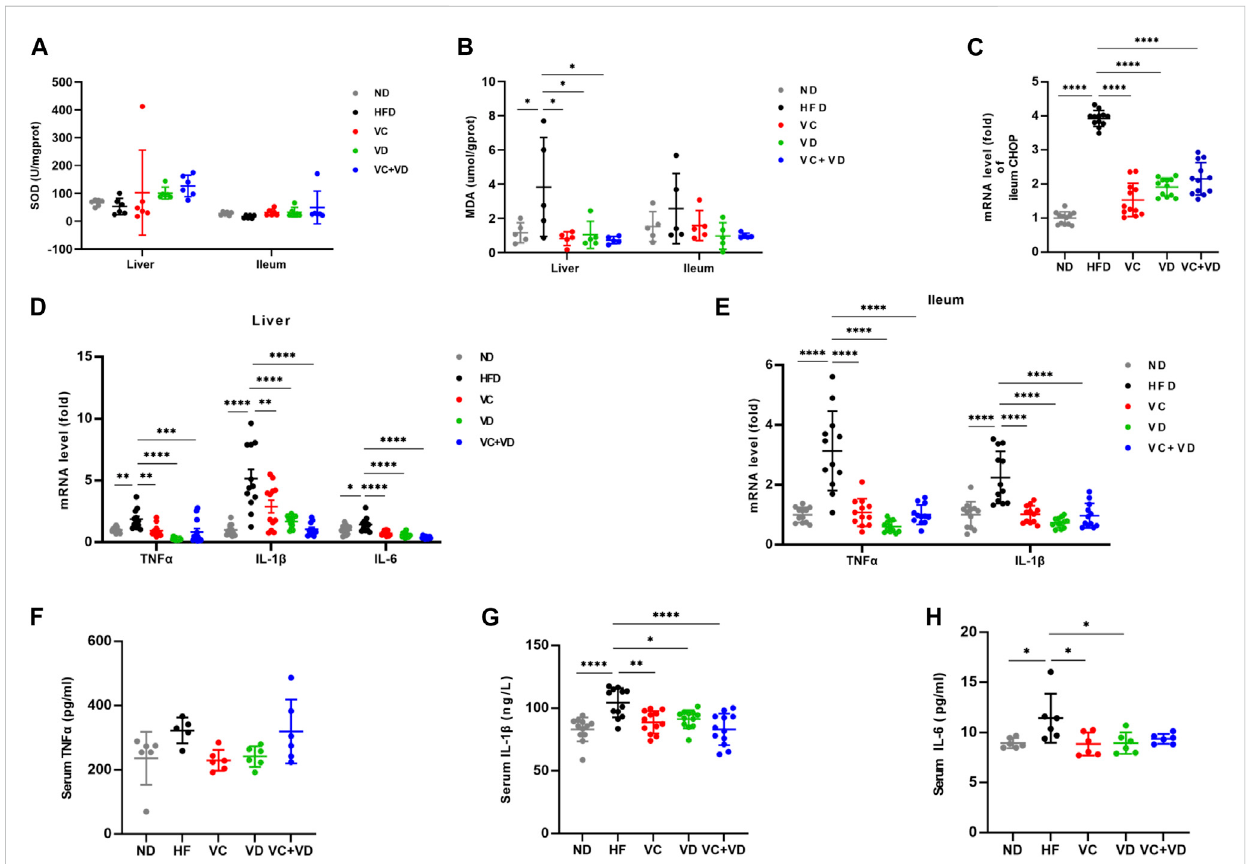
FIGURE 5 VCand VD 3 ameliorated oxidative stressand in fl ammation inthe gut-liver axis inobese mice. (A) SOD oftheliver and ileum. (B) MDA ofthe liverand ileum. (C) Gene expression of C/EBP-homologous protein in the ileum of mice. (D) Proin fl ammation-associated gene expression in the liver. (E) Proin fl ammation-associatedgeneexpressionoftheileum.ThegenelevelintheNDgroupwassetas1,andtherelativefoldincreasesweredeterminedby comparisonwiththeNDgroup. (F) SerumTNF α . (G) SerumIL-1 β . (H) SerumIL-6.Dataareshownasthemeans±SDs( n =12 mice/group),* p < 0.05,